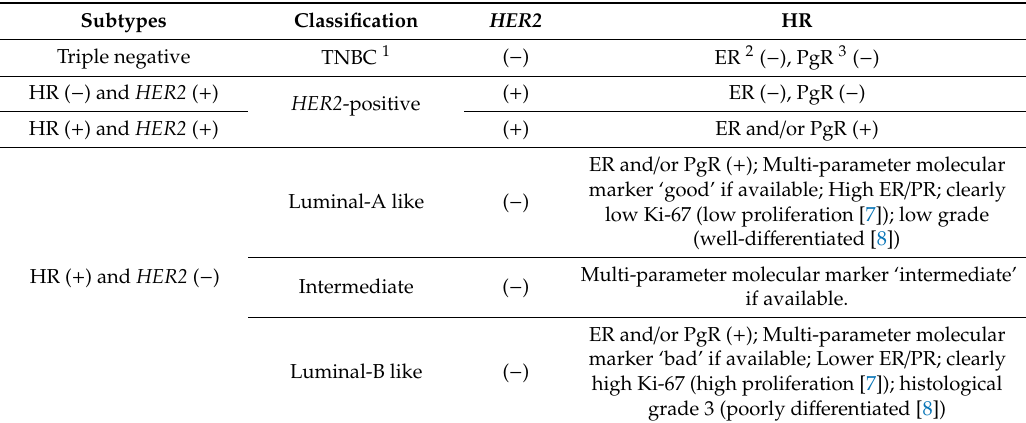
Table 1. Subtypes of breast tumor (summarized from St. Gallen conference of 2015 and